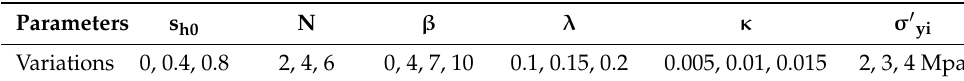
Table 1. Parameters and Initial